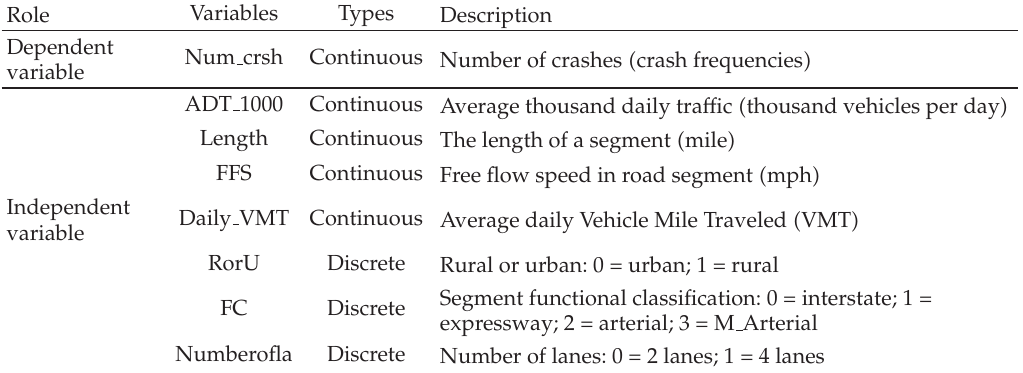
Table 1: ZINB models for segment crash frequency analyses and